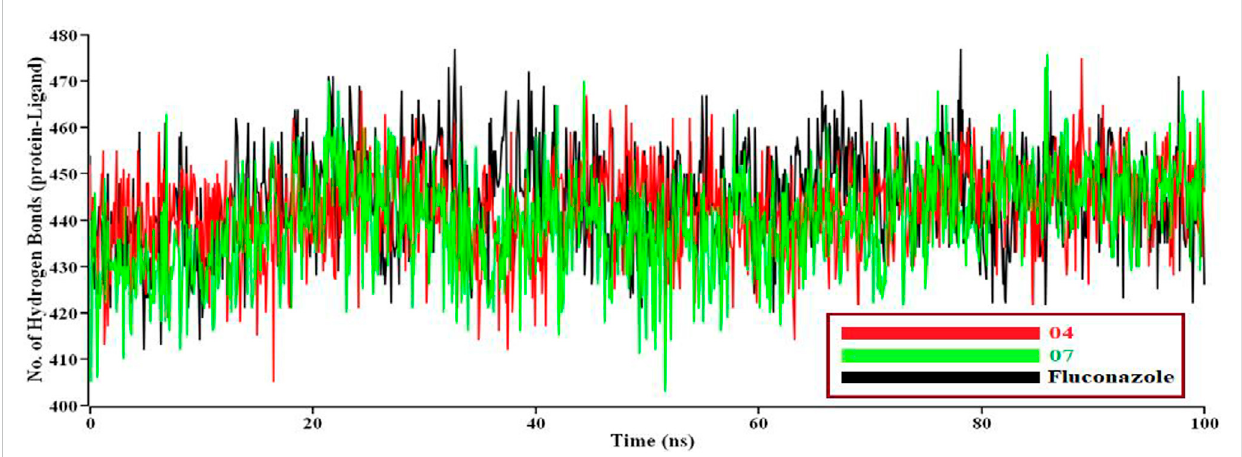
FIGURE 8 A total number of hydrogen bonds formed between protein-ligand complexes during M.D. simulations. Here, the red line indicates 04 complexes, and the green and black lines indicate 07 and the Fluconazole complex, respectively.